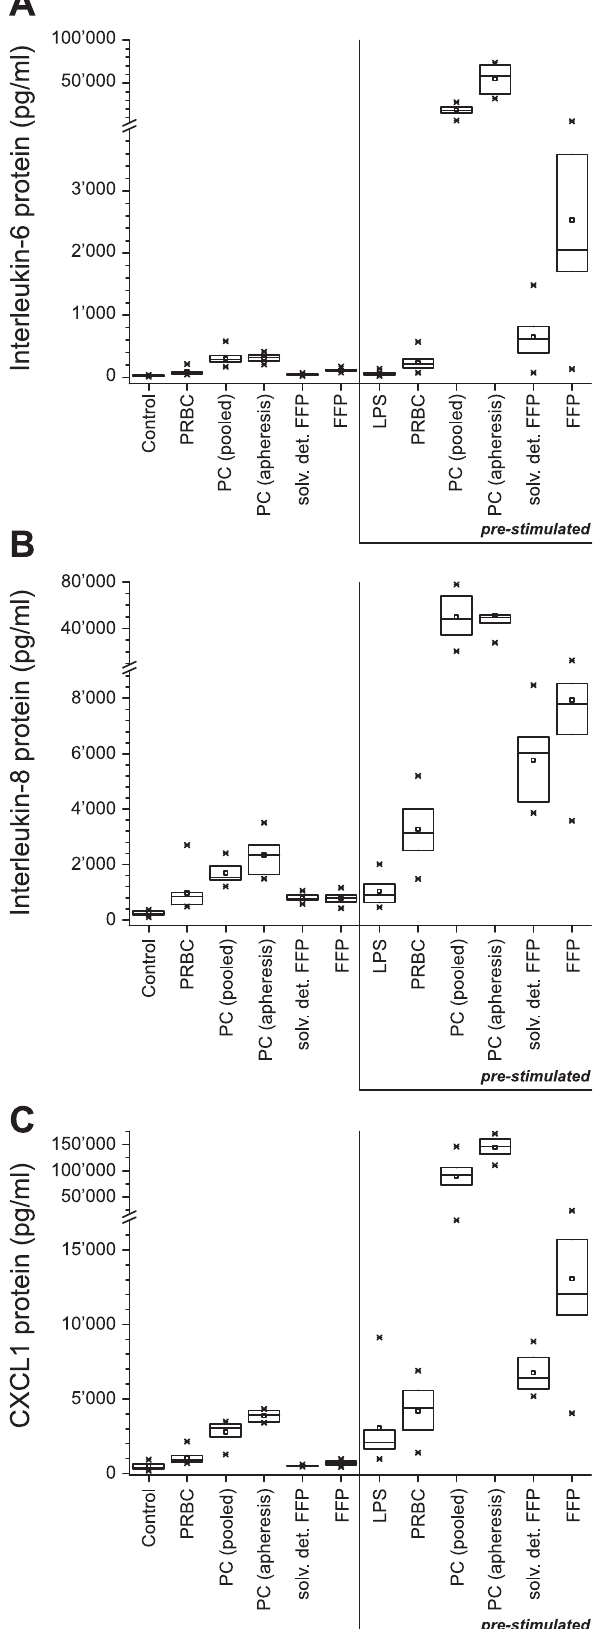
Figure 1. Inflammatory reaction of endothelial cells in response to exposure to different blood products. Concentra- tions of interleukin-6, IL-6 (A), interleukin-8 (IL-8) (B) as well as chemokine ligand 1 CXCL1 (C) in supernatants of human microvascular endothelial cells (HMVEC). HMVEC were stimulated with lipopolysac- charide (LPS) 2 m g/ml for 6 h (pre-stimulated) or not (unstimulated), followed by an 24 h-incubation with the according blood products packed red blood cells (PRBC), platelet concentrates (PC), pooled or apheresis, and solvent detergent or untreated fresh frozen plasma (FFP). Supernatants were collected and IL-6, IL8 and CXCL1 were determined. Results are shown as medians with interquartile